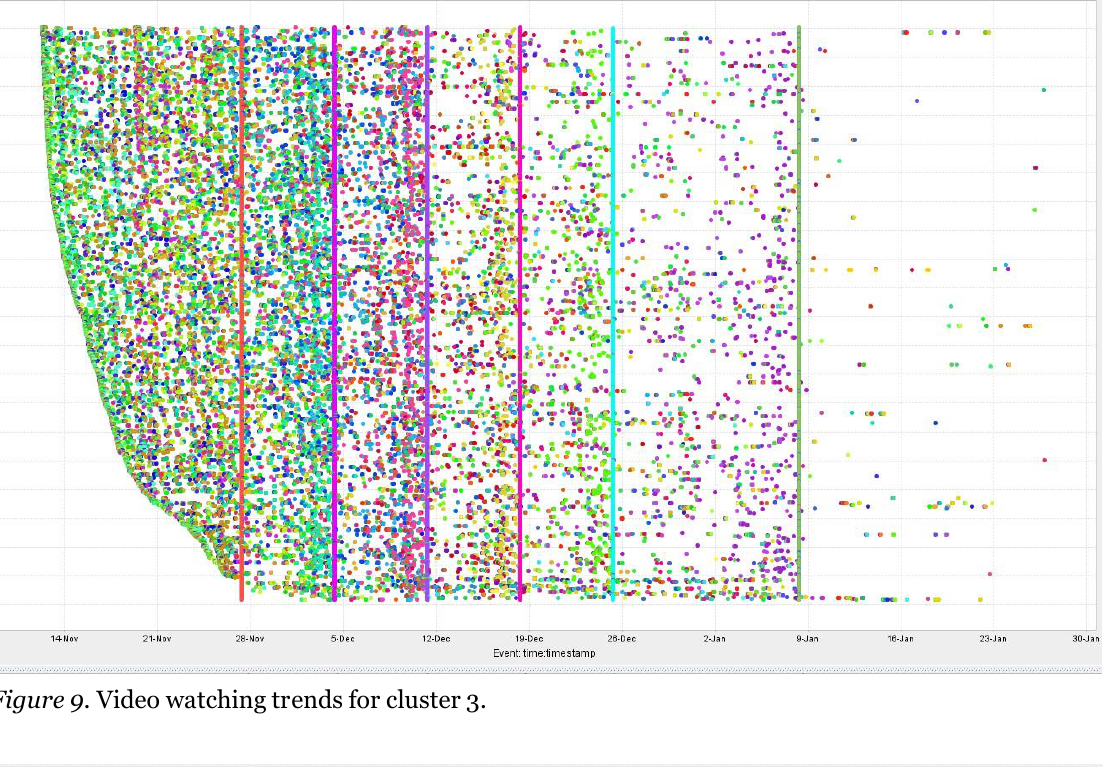
Figure 9. Video watching trends for cluster 3.